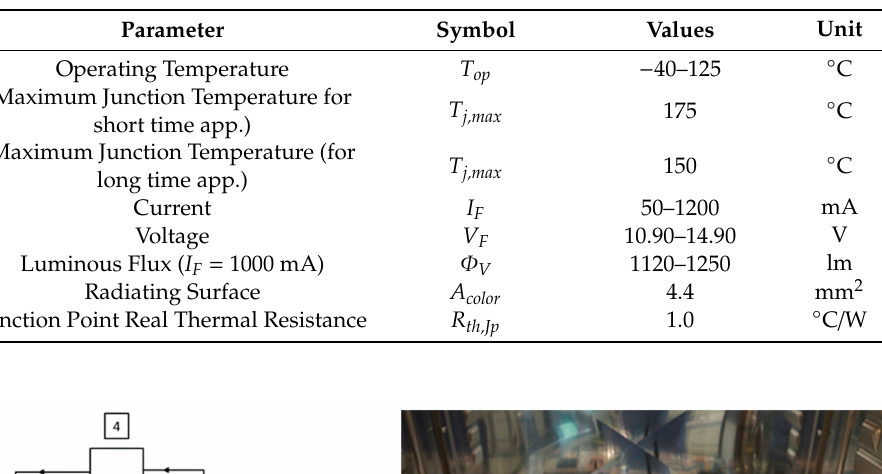
Table 2. Characteristics of the LED chip used in this study.